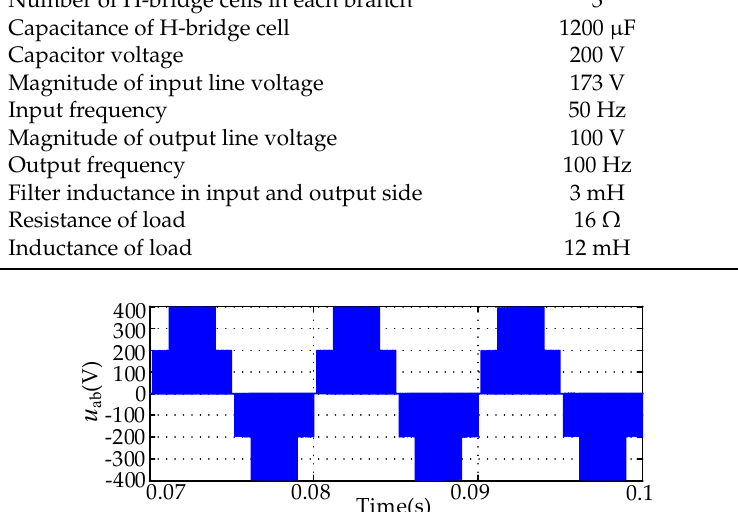
Figure 6. Output adjacent line-to-line voltage.